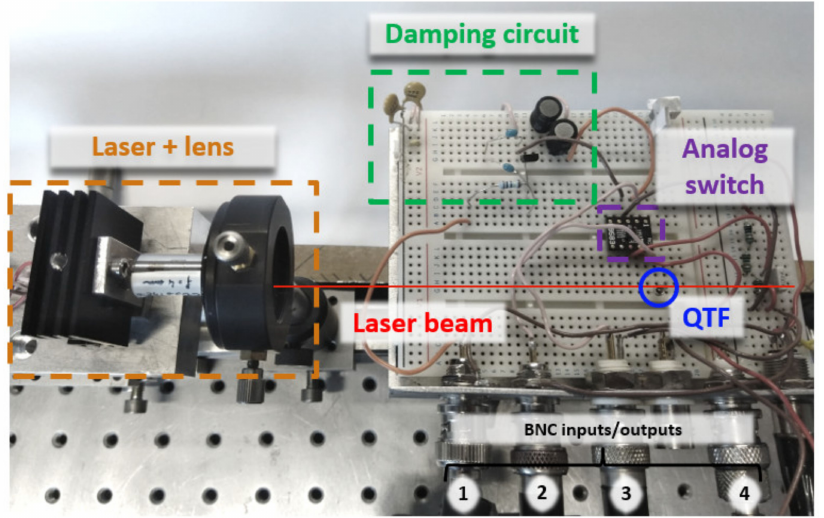
Figure 8. Picture of the setup-based on a standard “bare” on-beam Quartz-Enhanced PhotoAcoustic Spectroscopy (QEPAS) setup, plus the damping circuit. The QEPAS system is composed of a laser, a lens ( f = 4 mm) and a QTF. The QTF is plugged into a test breadboard along with the other electrical components. The analog switch (controlled by BNC3) allows to switch between the QTF electrical excitation (BNC4) and the damping circuit. The damping circuit is the parallel RLC circuit resonantly matched to the QTF central frequency (see previous sections) and is disabled through applying a voltage on the MOSFET gate (BNC1). The output of the QTF (BNC2) is connected to a transimpedance amplifier and a lock-in amplifier (not represented